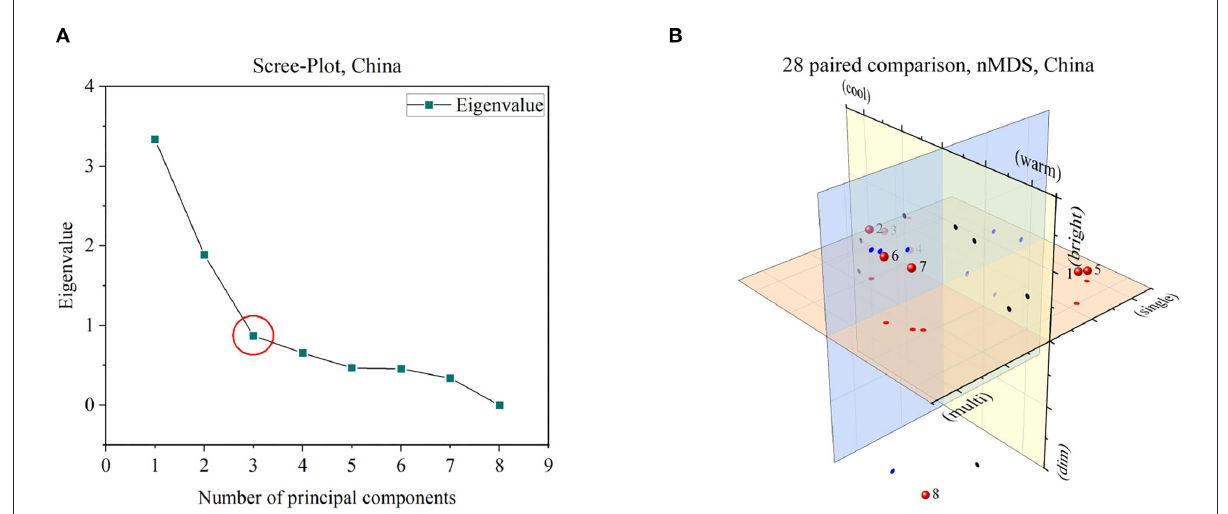
FIGURE4 (A) By setting three dimensions, resulted stress value of nMDS equals zero, which can be confirmed by a Scree-plot as well, marked with a red circle. (B) Three identified dimensions roughly labeled by illumination characteristics. Numbers 1–8 are representing lighting sceneries L1–L8. Plane projects are added: Red circles for the red plane, blue circles for the blue plane, and black circles for the yellow plane.